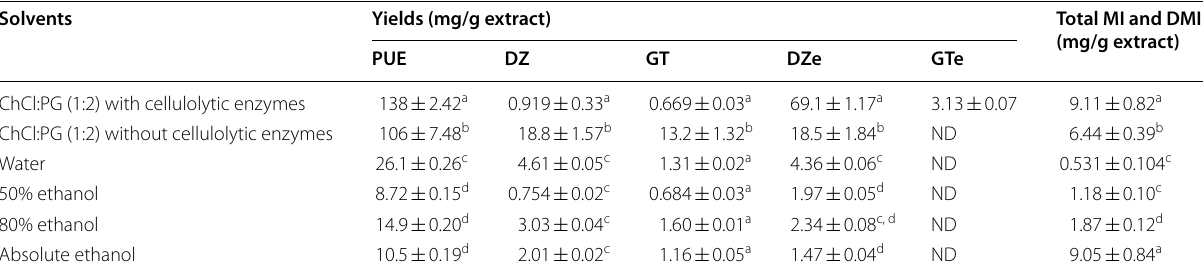
Table 2 Comparison of the efficacy of solvents for PM phytochemical extraction